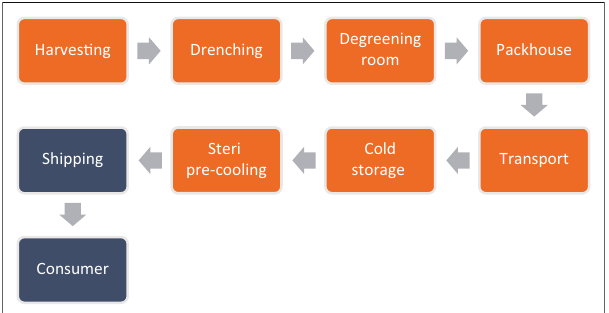
FIGURE 4: A typical citrus export cold